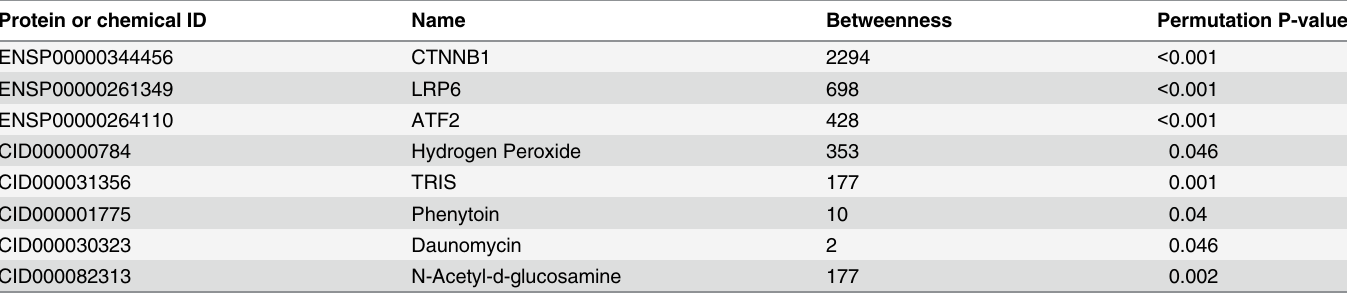
Table 1. Selected significant candidate genes and chemicals deemed to be closely related to esophageal cancer. Protein or chemical